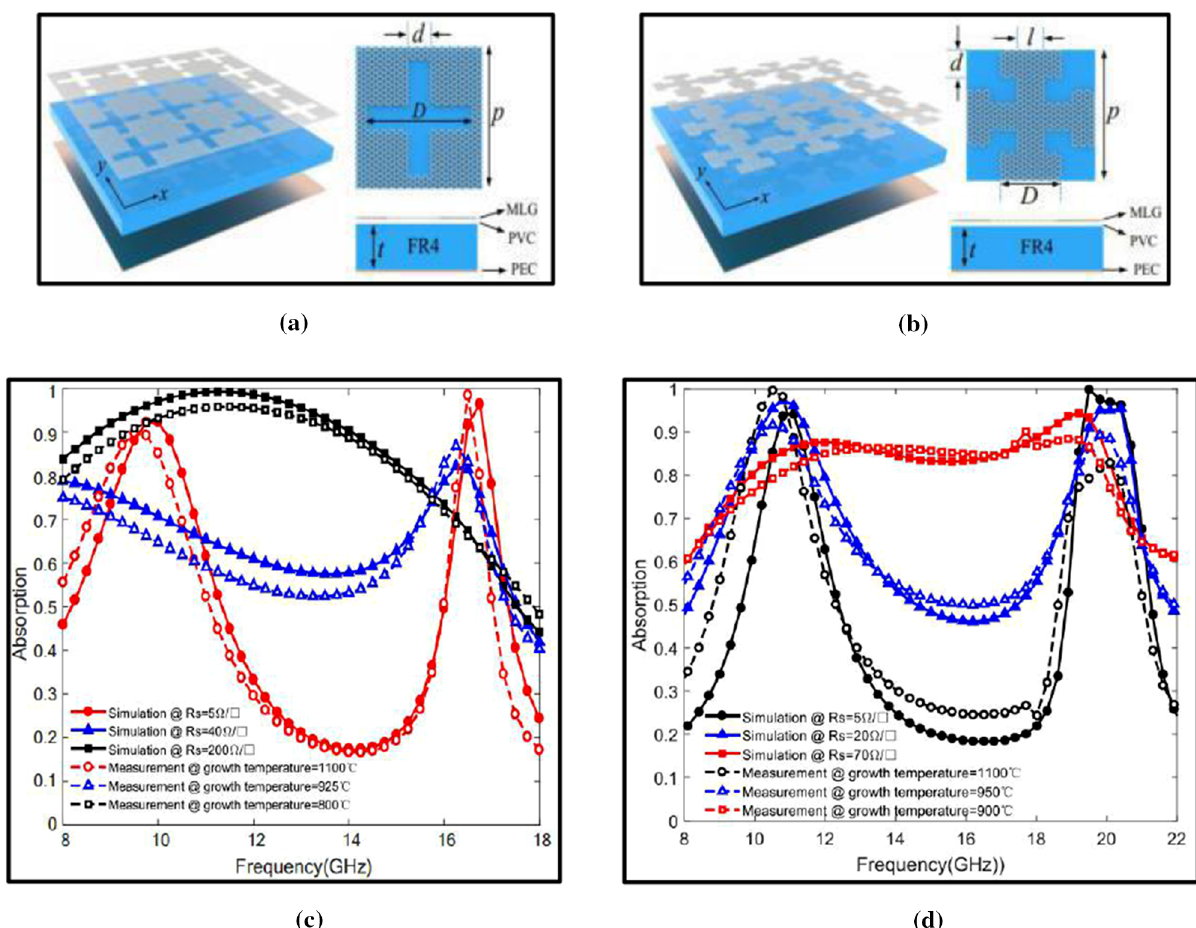
Fig. 6. (a) The con fi guration of absorber based on complementary cross-shaped patterns (Type-A). (b) The con fi guration of absorber based on Jerusalem cross patterns (Type-B). (c) The measured and simulated results of Type-A with different surface impedance of graphene. (d) The measured and simulated results of Type-B with different surface impedance of